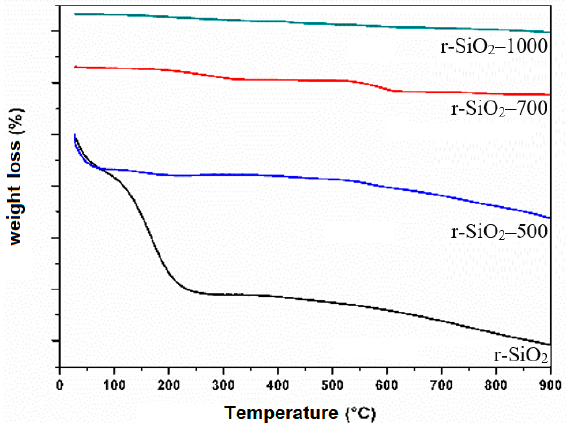
Figure 9. TGA spectra of the SiO 2 aggregate without heat treatment and heated at 500 °C, 700 °C, and 1000 °C.